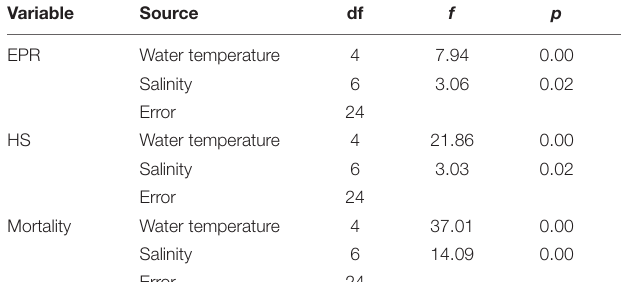
TABLE 2 | Two-way ANOVA without replication to test the effect of egg production rate (EPR), hatching success (HS), and mortality on water temperature and salinity. Variable